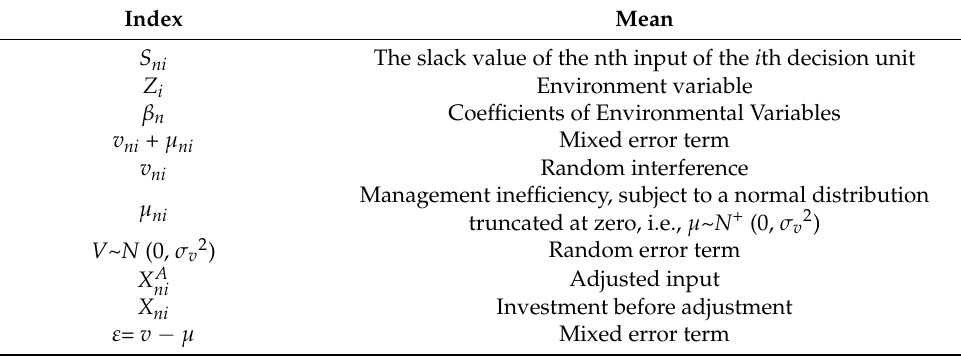
Table 2. The specific meaning of each indicator in the second